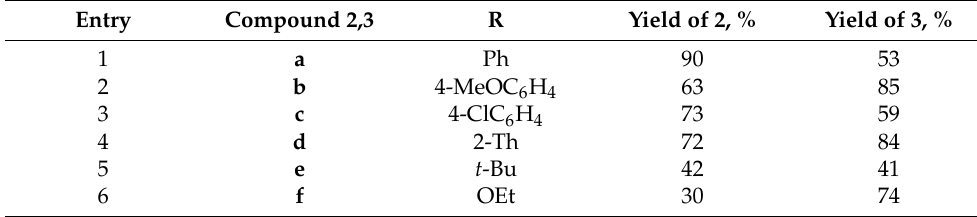
Table 1. The scope of products 2 and 3 .